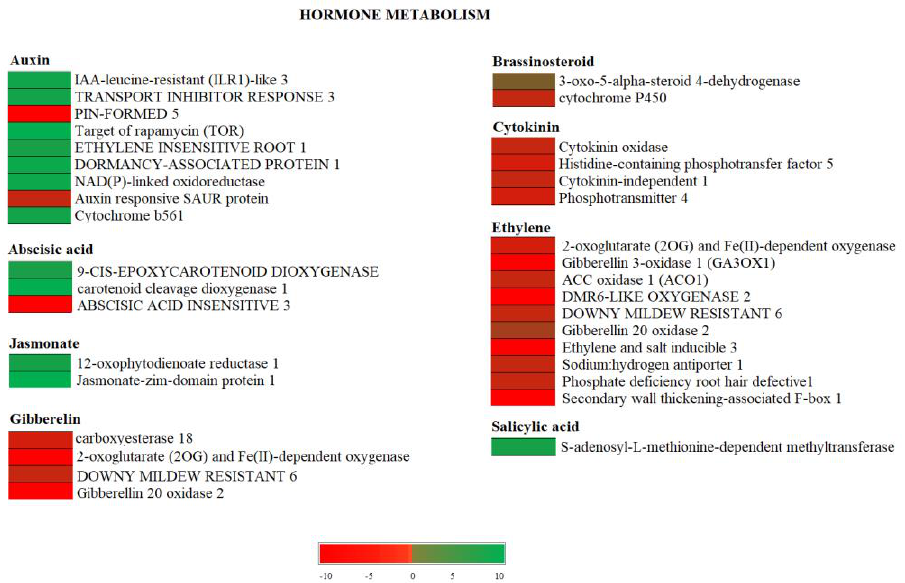
Figure 3. The figure shows hormone metabolism in Pistachio among the June “OFF” vs . June “ON” fruits comparison. The color scale indicates the log2 FC value. Red represents down-regulation and green represents up-regulation in June “OFF” fruits relative to June “ON” fruits.